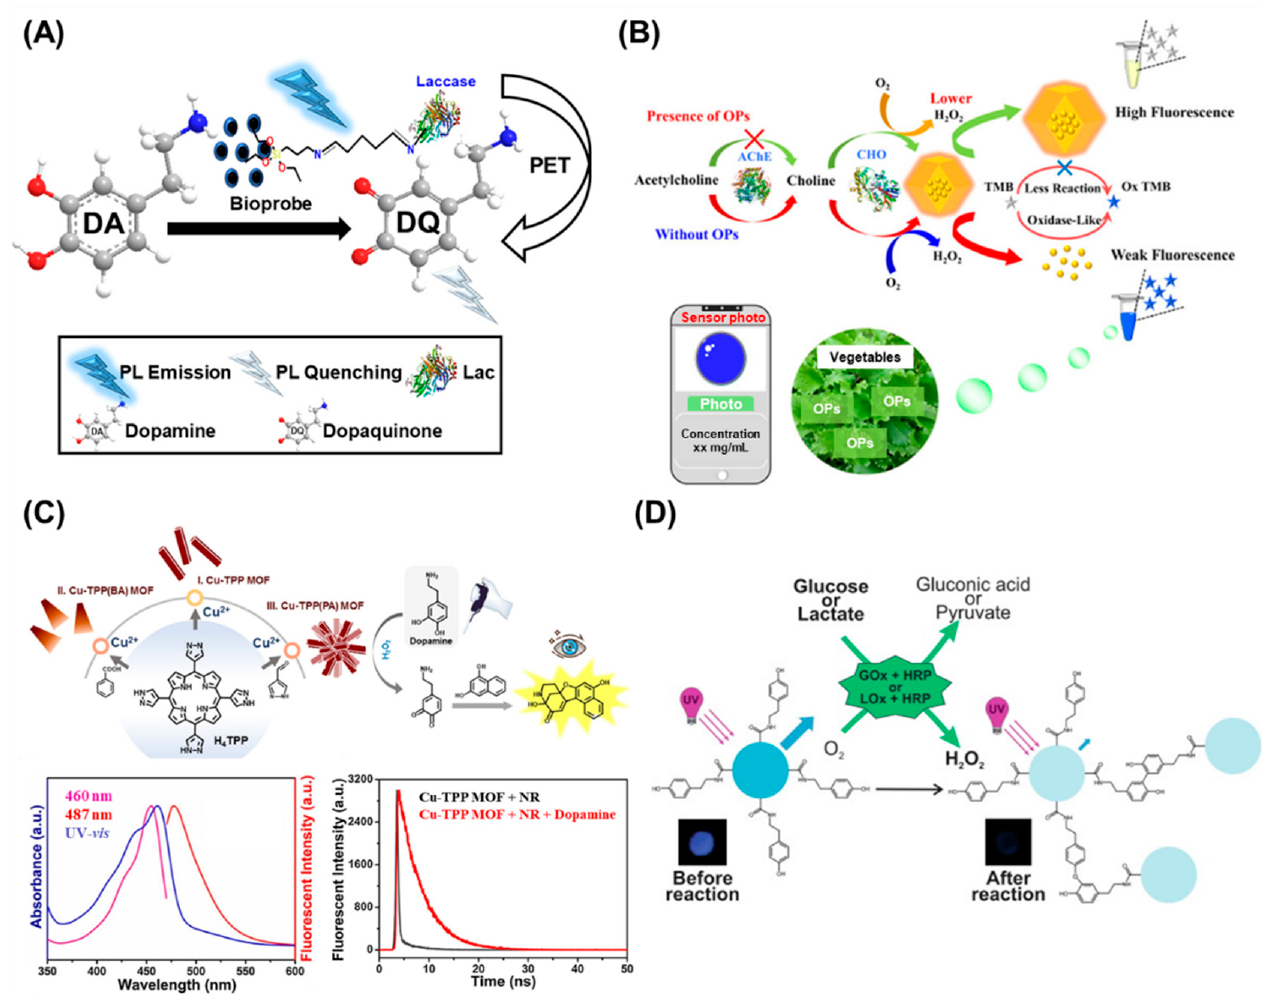
Figure 5. ( A ) Schematic representation for the plausible mechanism of photoluminescence quench- ing of bioprobe by DA, Reprinted with permission from ref. [92]. Copyright © 2021, Elsevier B.V., ( B ) Schematic Diagram of the Mechanism for the Detection of OPs, Reprinted with permission from ref. [99]. Copyright © 2021, American Chemical Society, ( C ) Schematic illustration of the sensing process of Cu-TPP MOFs toward DA (top), UV vis absorption spectra at 460 nm, fluorescence exci-